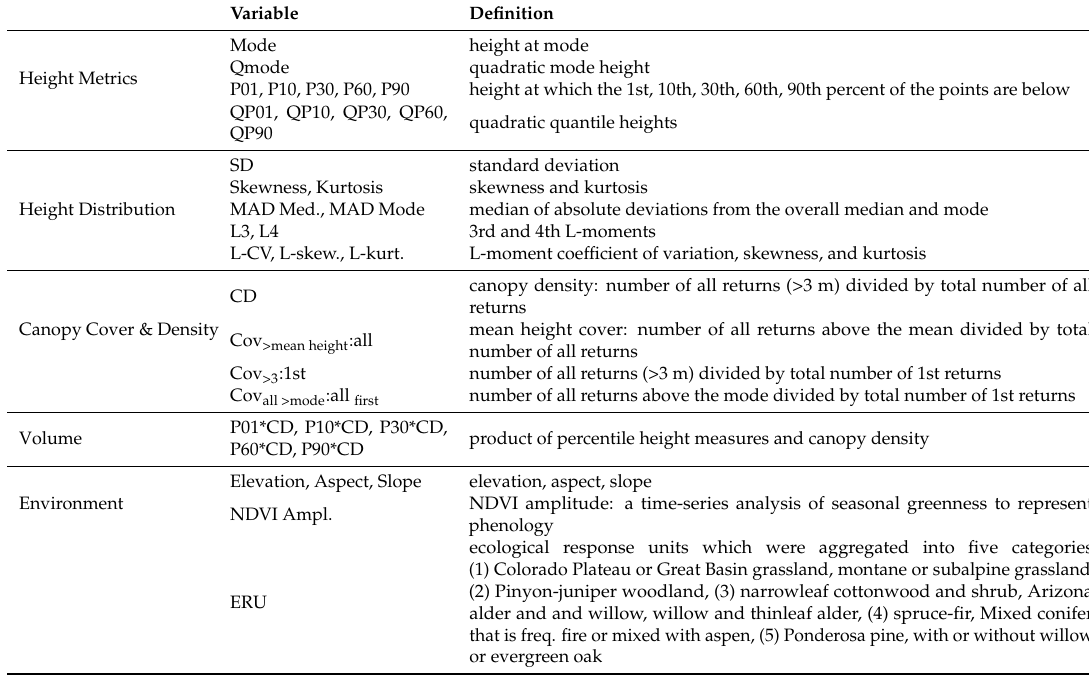
Table 3. Table of assessed